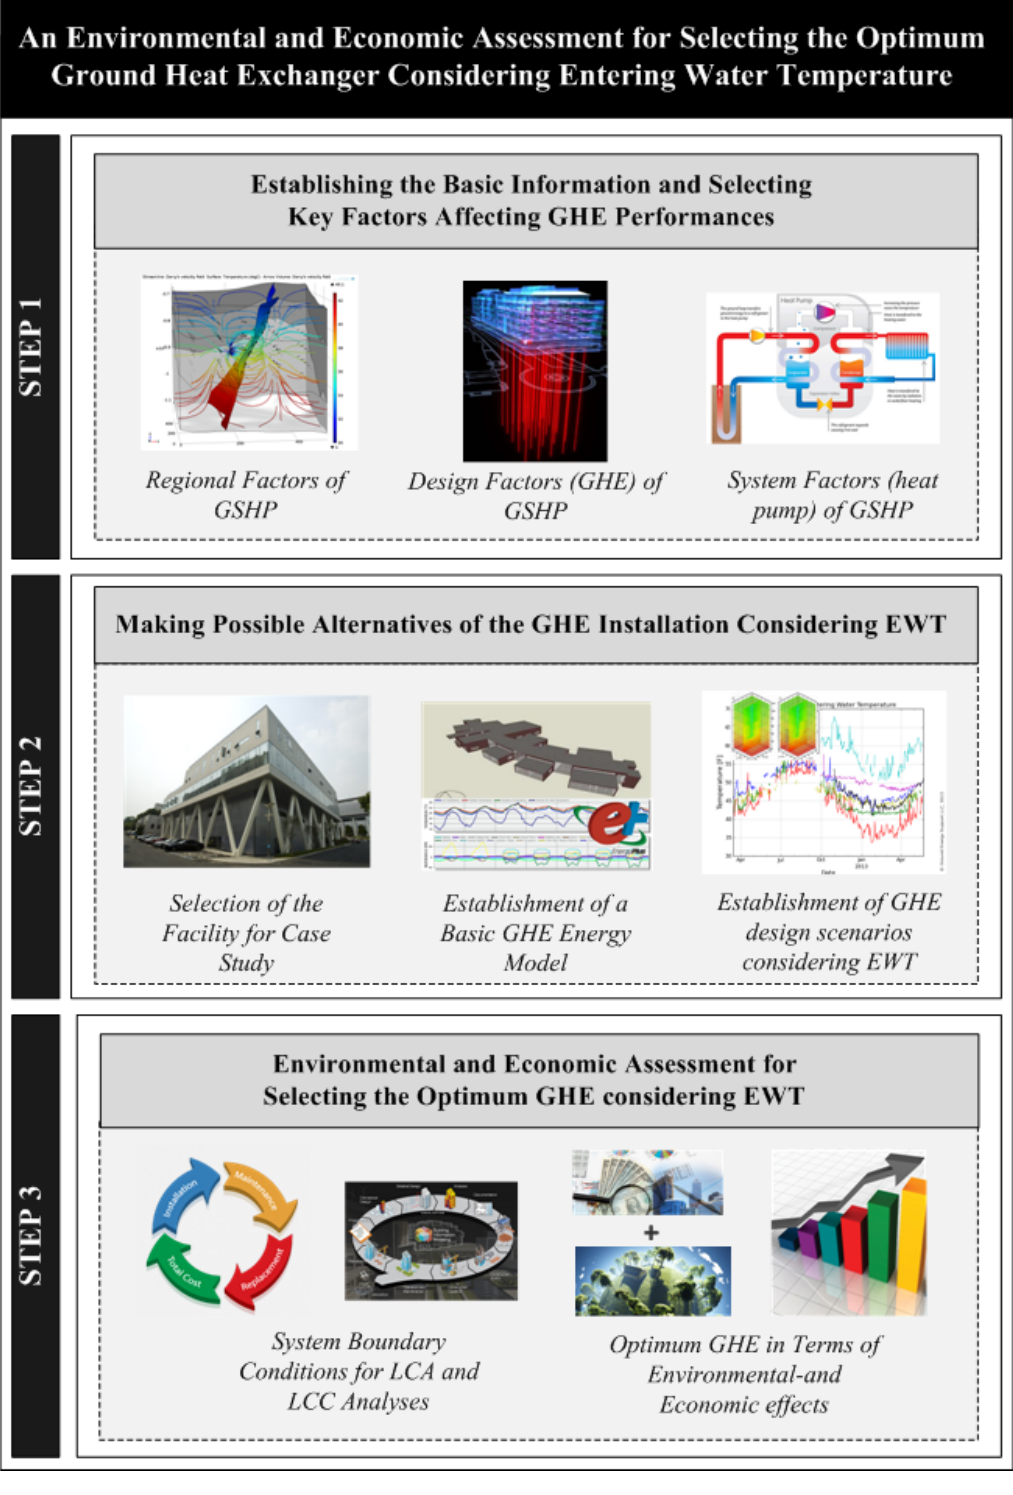
Figure 1. Framework of the